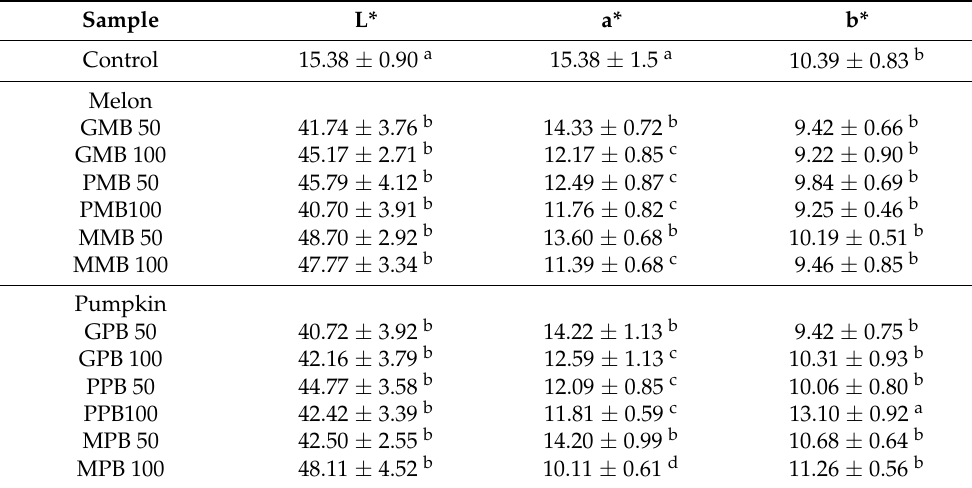
Table 3. Color parameters measured in raw samples. L*: Lightness; a*: red-green component; b*: blue-yellow